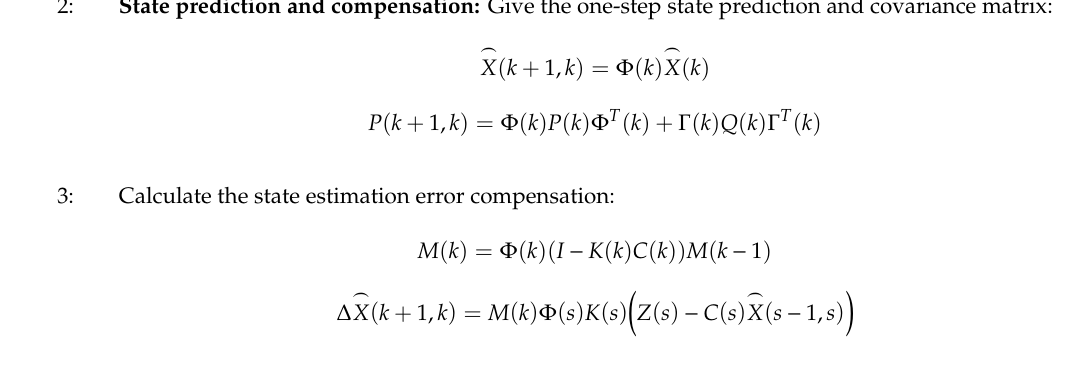
Algorithm 1: The cooperative localization algorithm based on State Estimation Error Compensation 1: Initialize: Assume that each robot in the system initially knows its pose with respect to a given reference coordinate frame. As Figure 1 shows, consider that at time t k , the follower robot receives the pose information from the leader robot with time delay after N Kalman filters at time t s